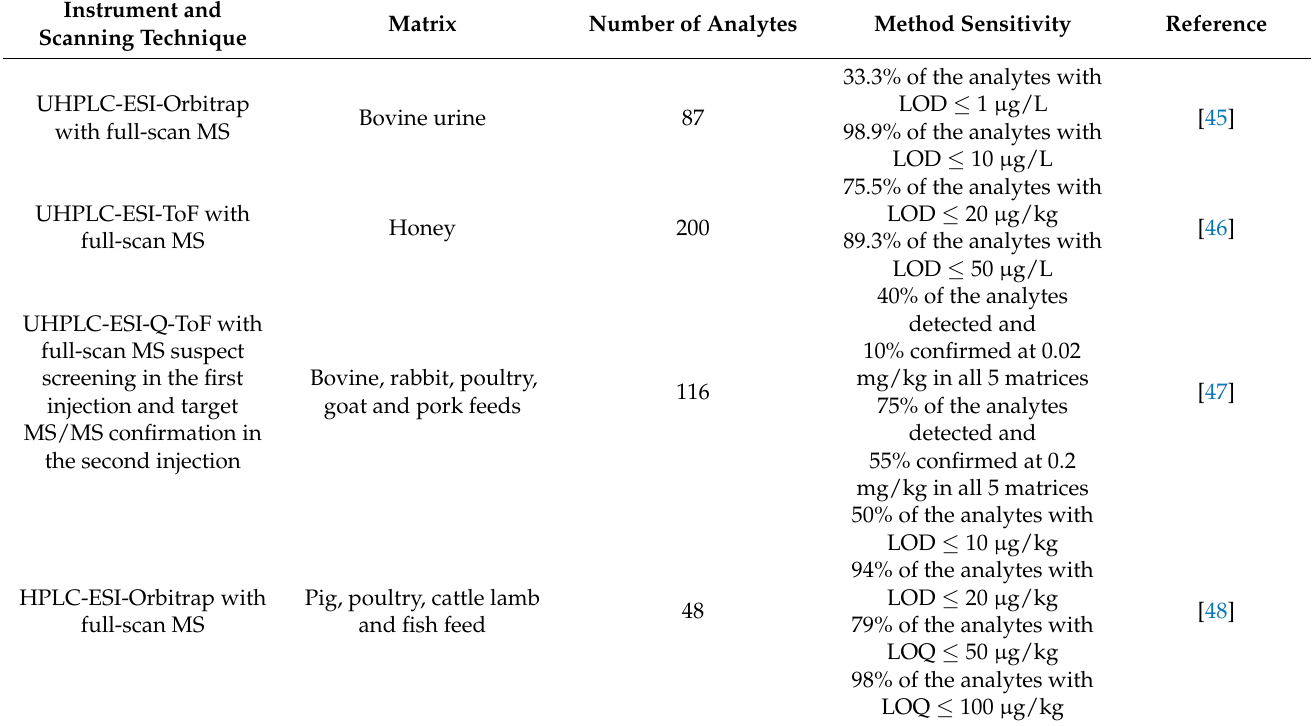
Table 2. Selected studies on veterinary drug residues analysis by